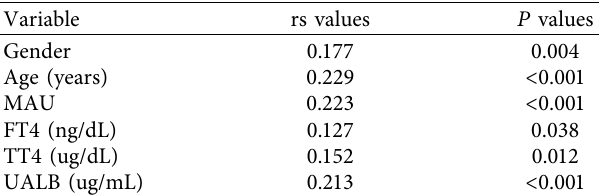
Table 3: Correlation of thyroid nodules and